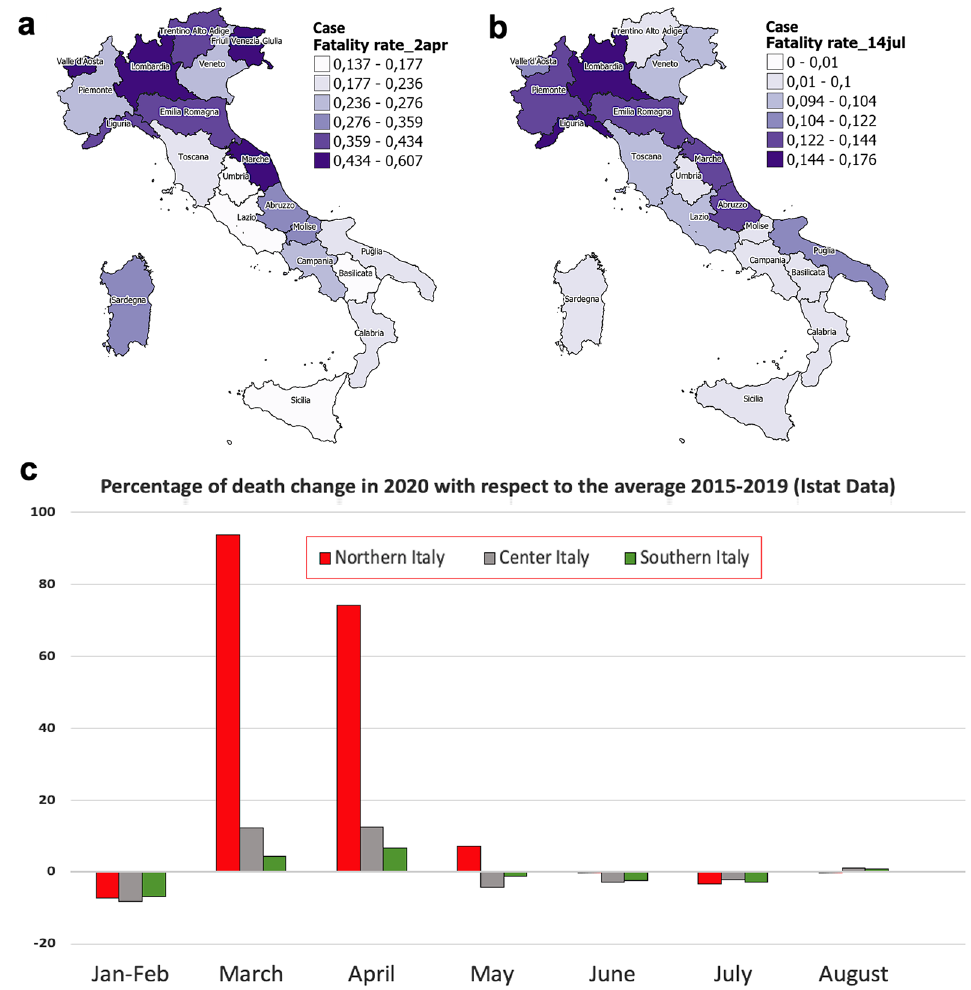
Figure 1. ( a ) Color geographic maps of the apparent case fatality rate in the various regions on April 2, 2020 and on July 14, 2020 ( b ), data released by the Italian Ministry of Health 4 . Maps were realized with QGIS 3.10 (https:// qgis. org/ en/ site/). ( c ) Percentage of deaths change in 2020 with respect to the average taken in the period 2015–2019 (ISTAT 22